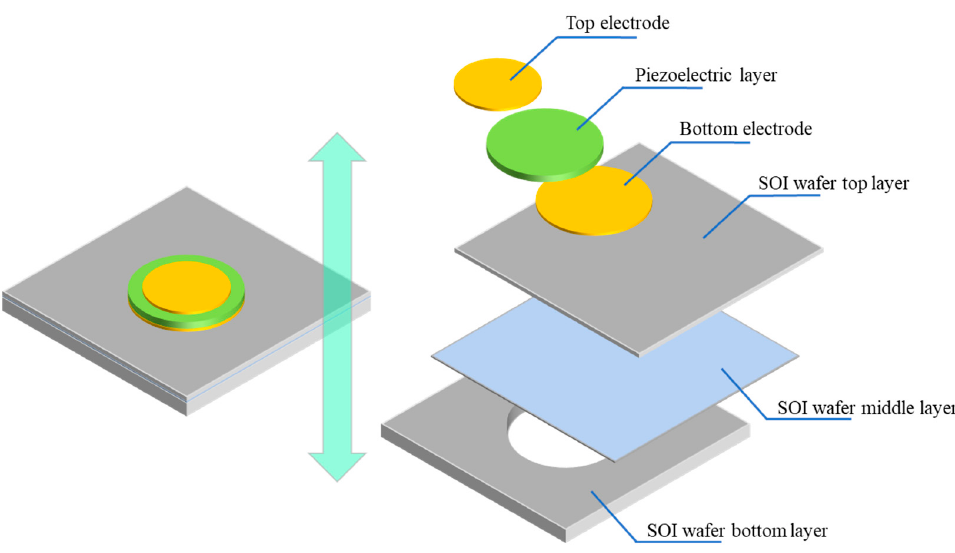
Figure 2. The structure of the array element of PMUT.